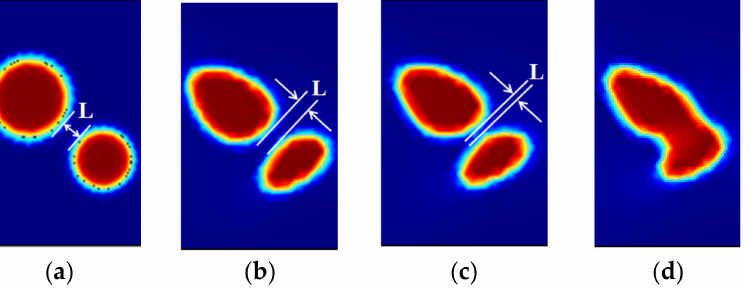
Figure 3. Determination of oil droplet deformation. ( a ) L t = 0.5 mm, ( b ) L t = 0.3 mm, ( c ) L t = 0.2 mm, ( d ) L t =